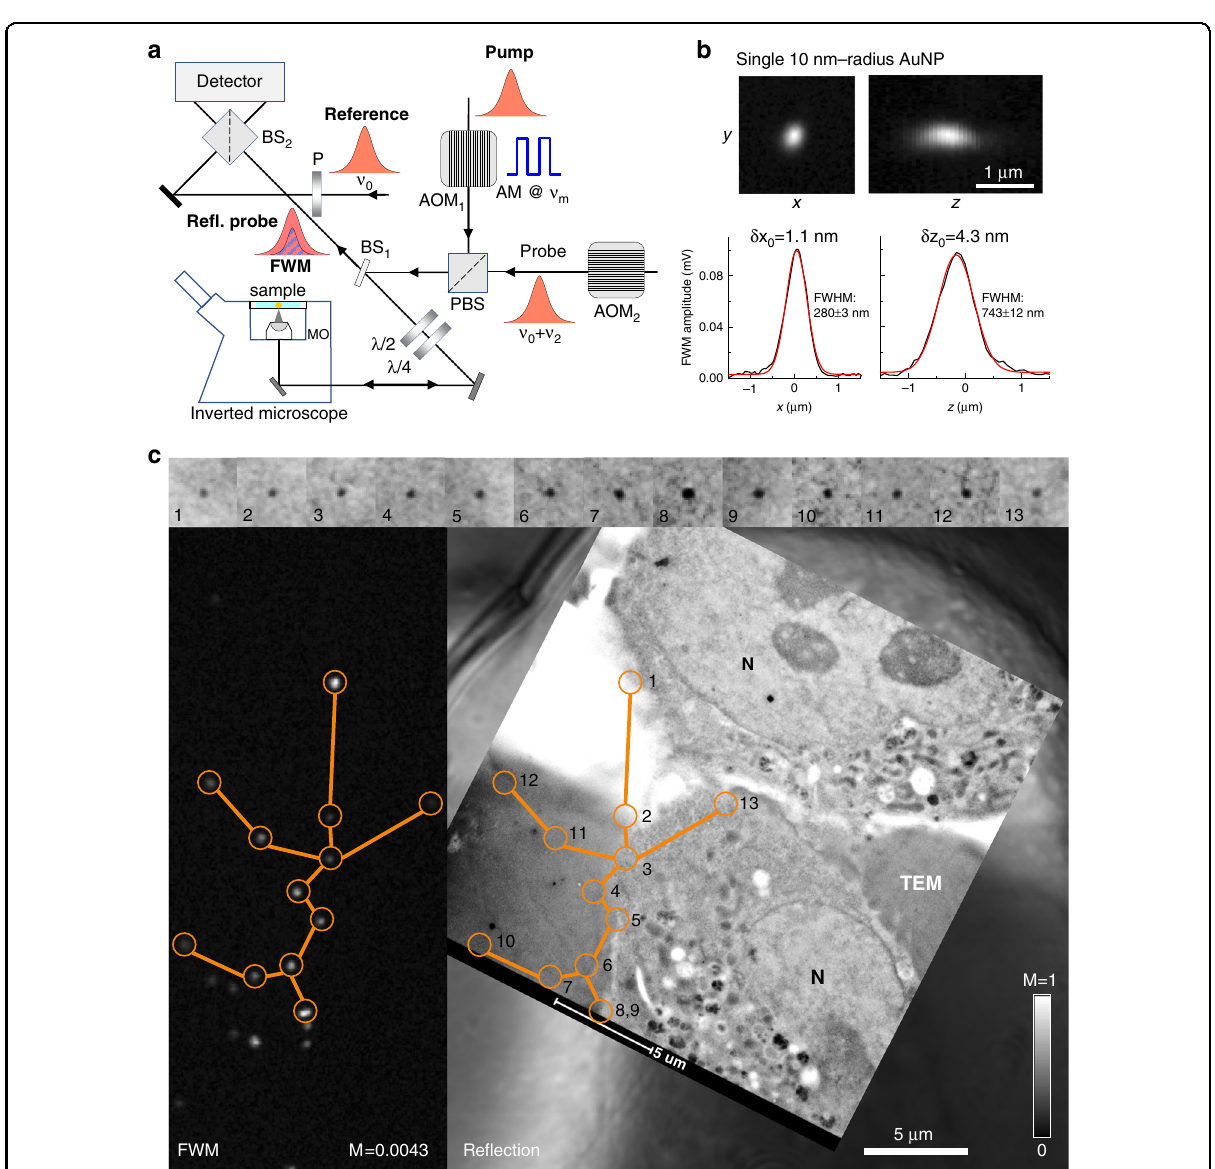
Fig. 1 Correlative light electron microscopy using FWM imaging. a Sketch of FWM setup. Short optical pulses in resonance with the LSPR of AuNPs are focused onto the sample, using an inverted microscope, and generate a FWM fi eld which is collected in epi-geometry, detected with a heterodyne interference scheme (see Methods). AOM: acousto-optic modulator. (P)BS: (polarising) beam splitter. P: polariser. MO: microscope objective. b Example of volumetric FWM microscopy on a single 10nm-radius AuNP, with line-pro fi les along x and z at the y -position in the centre of the AuNP and corresponding Gaussian fi ts (red lines). The centroid localisation precision ( δ x 0 , δ z 0 ) and the fullwidth at half maximum (FWHM) obtained from the fi t are indicated. c CLEM of 10nm-radius AuNPs bound to the EGF protein in HeLa cells. Individual AuNPs are detected background-free in FWM (left), measured directly on 300 nm thick resin sections post-cell fi xation, ready for EM analysis. The same pattern is found in TEM, highlighted by the orange circles. Two cells are visible, with their nucleus indicated (N). The nucleus is surrounded by the organelle-containing cytoplasm. The top row shows crops (0.2 µm × 0.2 µm) of the TEM image for each AuNP as numbered. The confocal re fl ection image simultaneously acquired with FWM is shown underneath the TEM image. Greyscales are from 0 to M as indicated (M = 1 correspond to 31 mV rms detected, see also Methods for details of the excitation and detection